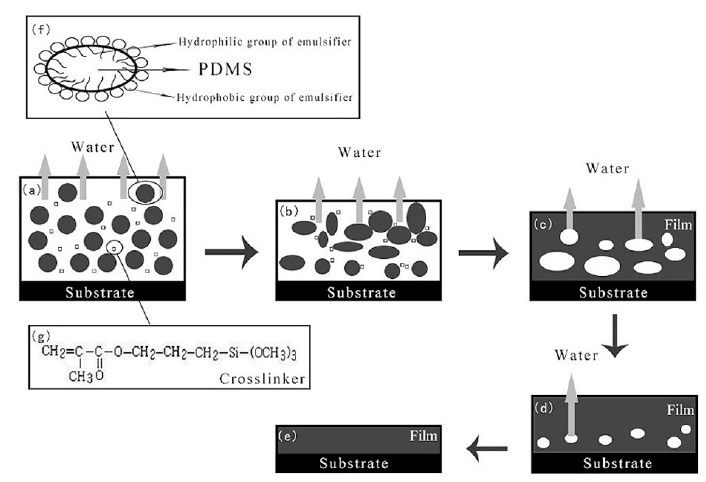
Figure 3. Schematic model of film formation process of silicone emulsion. ( a ) the early stage of painting; ( b ) the early stage of cross-linking reaction; ( c ) after drying on surface; ( d ) the cross-linking reaction is completed; ( e ) completely cured; ( f ) basic structure of silicone emulsion; ( g ) structural formula of crosslinker.